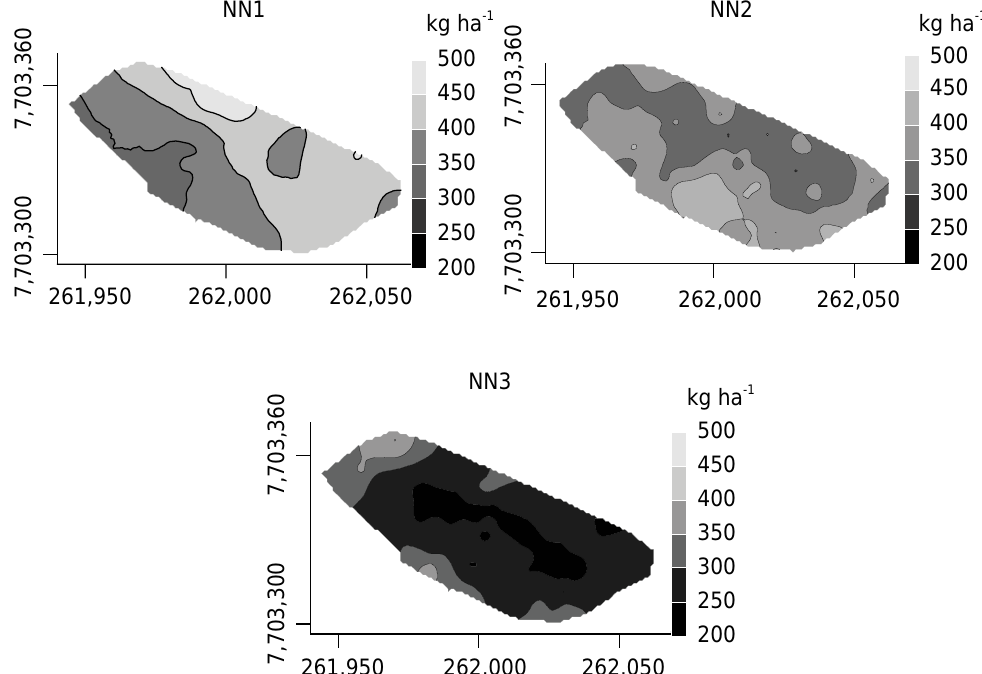
Figure 2. Spatial distribution of nitrogen needs in the three studied